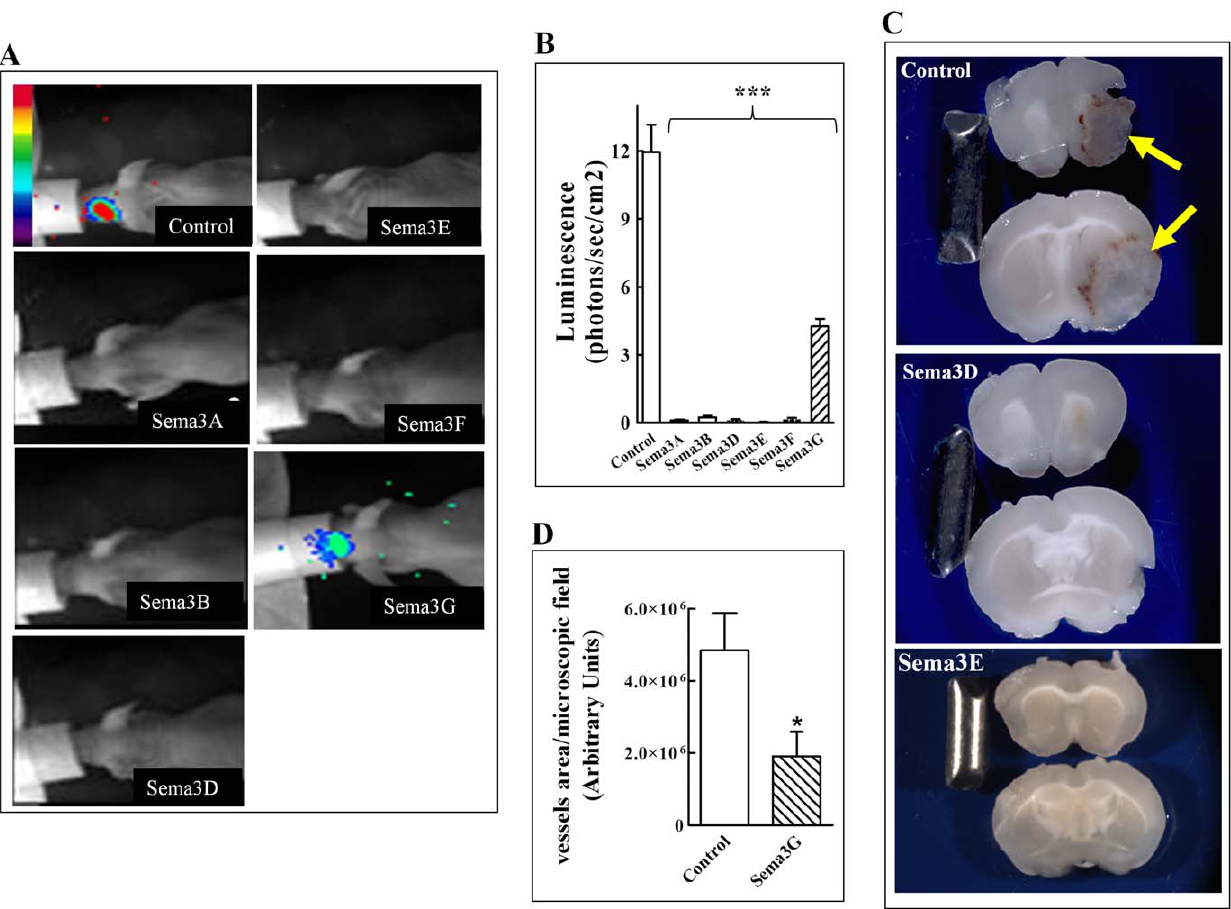
Figure 4. The effect of class-3 semaphorins on the development of tumors from U87MG glioblastoma cells implanted in the brain cortex: ( A ) U87MG cells infected with control lentivirus or infected with lentiviruses directing expression of six different semaphorins (Sema3x) were implanted in the brain cortex of CD1 nu/nu mice (8 mice/group) as described. Tumor growth was followed in vivo using bioluminescence imaging following administration of D-luciferin as described. Shown are representative pictures of pseudo colored overlay images of the bioluminescence signal intensity superimposed on mice. The pictures were taken 22 days after the implantation of the tumor cells. ( B ) Quantification of luminescence in mice in which control or semaphorin expressing tumor cells were implanted as described above. Luminescence was measured 22 days after the implantation of the cells as described in materials and methods. Each bar represents the average luminescence from 8 different mice. ( C ) Brains from mice injected with U87MG cells infected with empty control lentiviruses (Control), or lentiviruses directing expression of sema3D or sema3E were sliced transversely and the slices were photographed. A large brain tumor is seen in the control (yellow arrows) whereas no tumors can be detected in brains in which sema3D or sema3E expressing U87MG cells were implanted. ( D ) Tumor sections from the brain cortex of mice implanted with U87MG cells infected with empty control lentiviruses (Control), or lentiviruses directing expression of sema3G (sema3G) were sectioned perpendicularly at the injection site, fixed in formalin, and embedded in paraffin. Paraffin sections (4 m m) were stained with anti-vWF using a fluorescent microscope as described in materials and methods. Microscopic fields were photographed and the vessel area per microscopic field was calculated as described in materials and